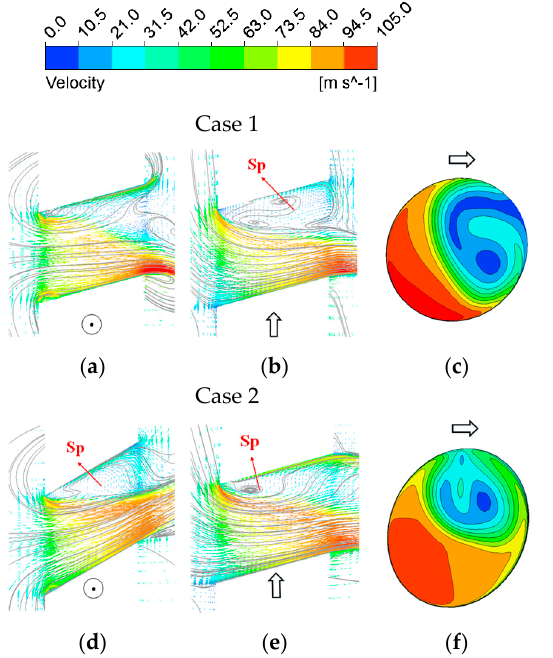
Figure 30. Streamlines and velocity contours under the condition of same β 0 and different α 0 . ( a – c ) α 0 = 15 ◦ , β 0 = 15 ◦ , N = − 3000 r/min, i = − 37.5 ◦ , C d = 0.528; ( d – f ) α 0 = 30 ◦ , β 0 = 15 ◦ , N = − 2000 r/min, i = 38.3 ◦ , C d = 0.663. ( a , d ) Meridian section; ( b , e ) circumferential cross-section; ( c , f ) velocity contour of the exit